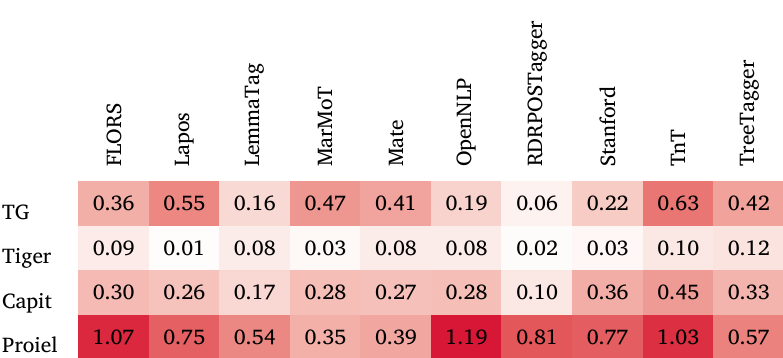
Figure 6: Distribution of deltas acc max (cid:0) acc min for POS-taggers in %, based on a three-fold cross-validation. The more saturated the cell color, the higher the